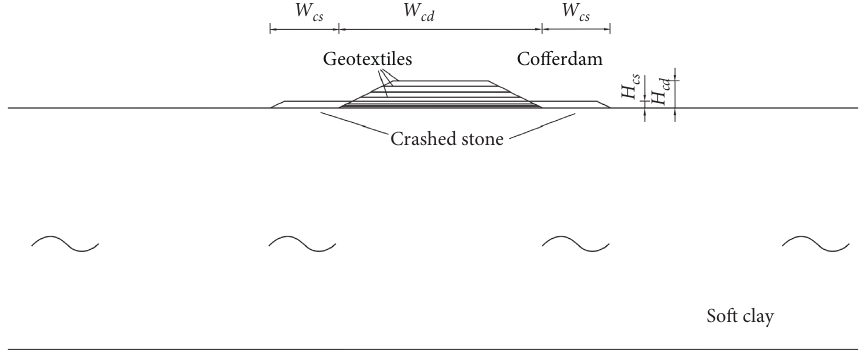
Figure 2: Typical embankment section.